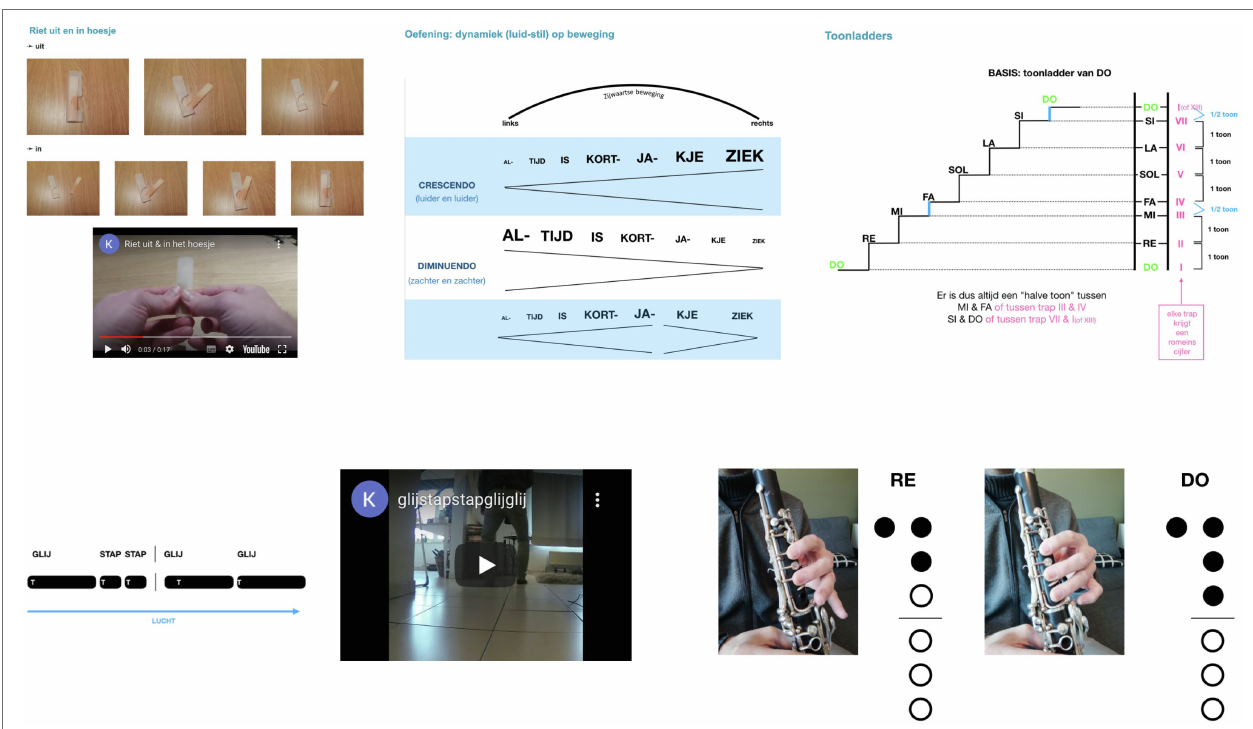
FIGURE 1 | Supporting material accessible via a dedicated website. This involved videos on different aspects of the learning process, visual representation of tasks (e.g., rhythm for improvisation) or learning content (e.g., new note fingering), as well as sound-files and other didactic material. Screenshots taken from private Youtube channel “Klarinetles”: (left) Luc Nijs, “Riet uit and in hoesje [reed in and out cover]”, YouTube video, 0:18, 01/04/2021; (middle) Luc Nijs, “glij stap stap glij glij [glide step step glide glide]”, YouTube video, 0:12,